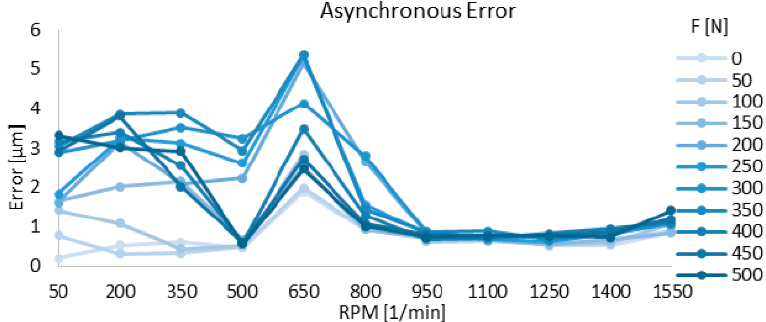
Figure 61. Dependency of asynchronous error on spindle speed and load [43].